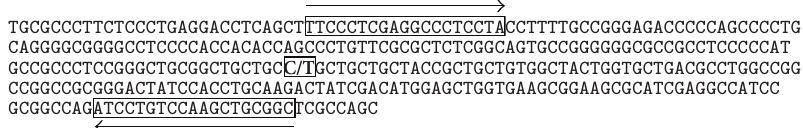
Figure 2: Localization scheme of the polymorphism at +869 C/T, situated inside exon 1, positions of the forward and reverse primers of the 294Bp fragment are